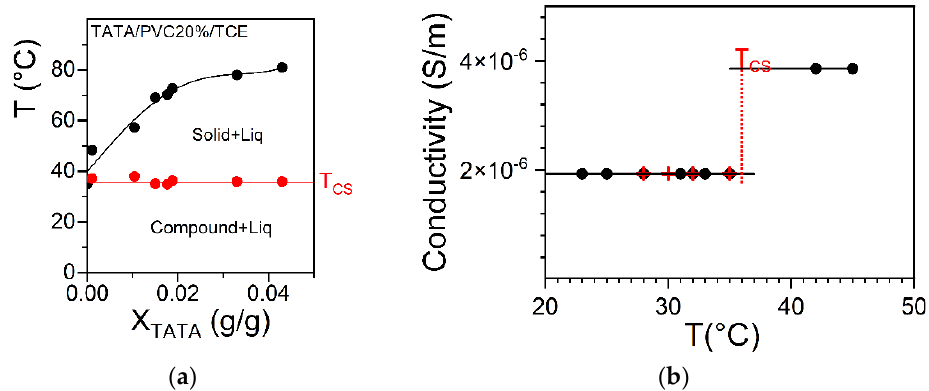
Figure 10. ( a ) Temperature–concentration phase diagram for a fixed PVC concentration (20% w / w ); T CS is a non-variant event corresponding to the incongruent melting of the TATA/TCE compound [22,25]. ( b ) Conductivity as a function of temperature for hybrid PVC/TATA gels with 20% w / w PVC concentration; T CS is the transition temperature seen in the T–C phase diagram. Measurements performed upon heating ( • ) and cooling ( (cid:58)